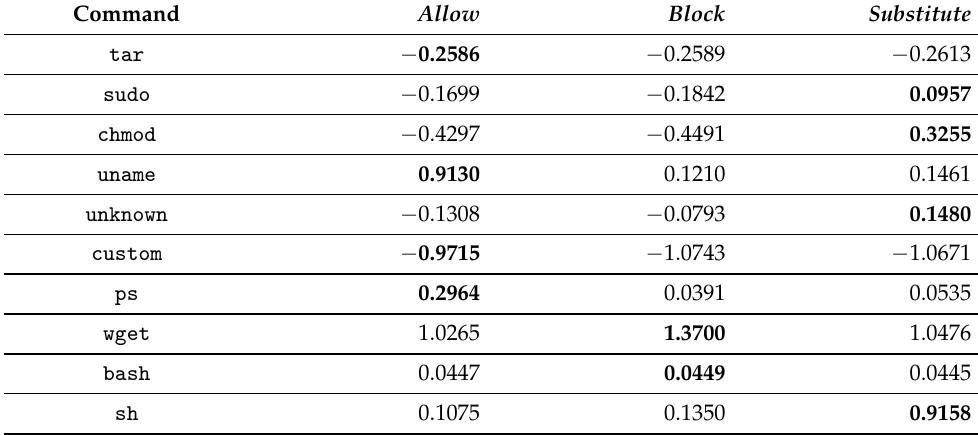
Table 6. q -Values of some commands of